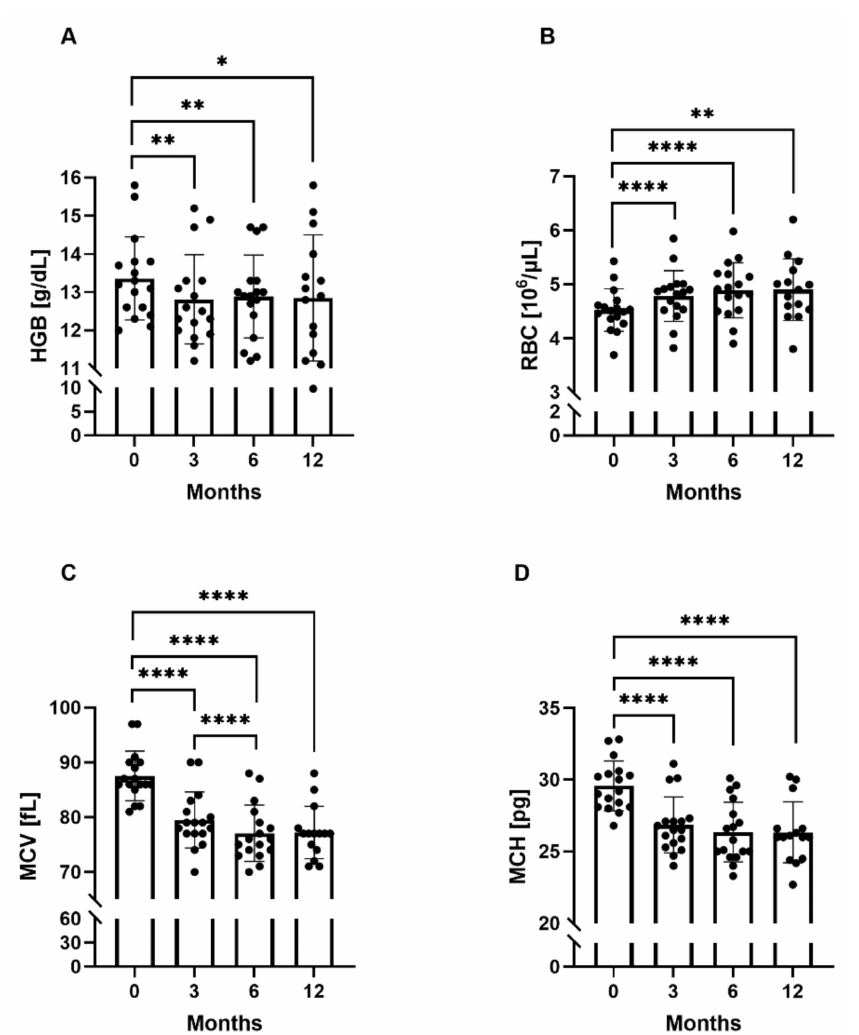
Figure 1. Red blood cell parameters at the study time points. ( A ) Mean hemoglobin concentrations (Hgb) at the study time points. ( B ) Mean red blood cell count (RBC) at the study time points. ( C ) Mean corpuscular volume (MCV) at the study time points. ( D ) Mean corpuscular hemoglobin (MCH) at the study time points. * p < 0.05, ** p < 0.01, **** p < 0.0001 (paired t